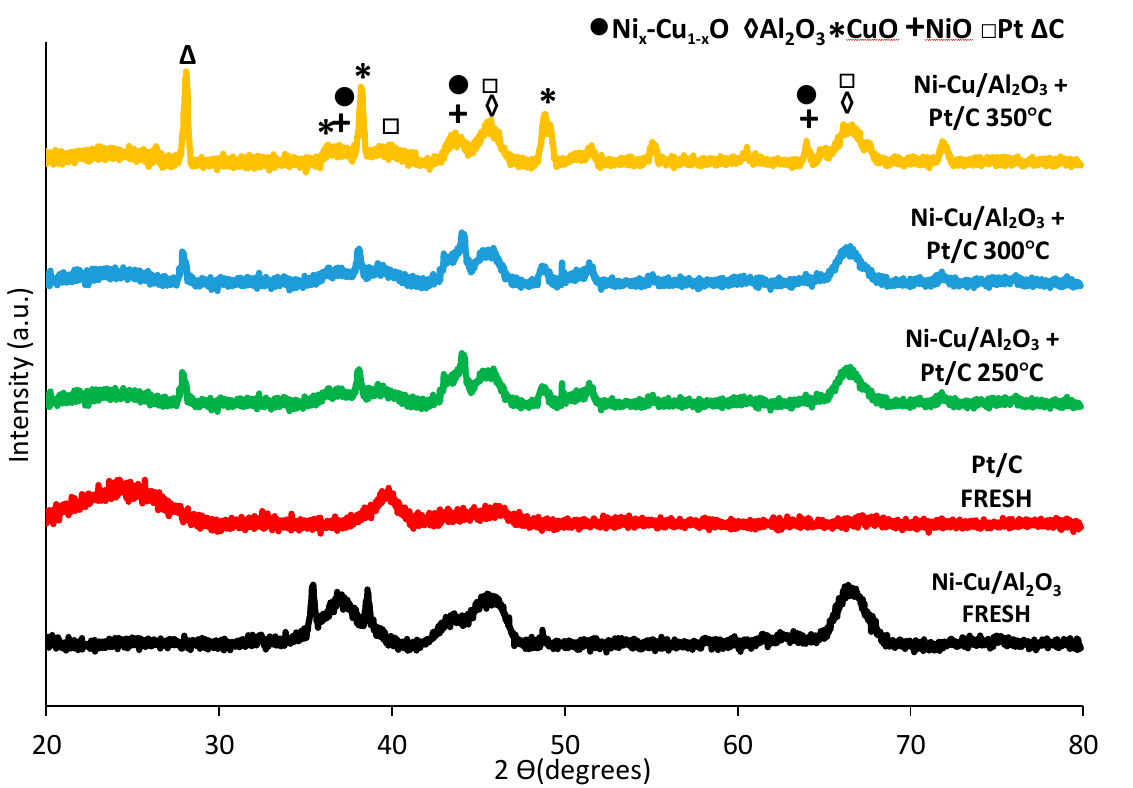
Figure 13. XRD of the fresh and recovered Ni ‐ Cu/Al 2 O 3 ‐ Pt/C.